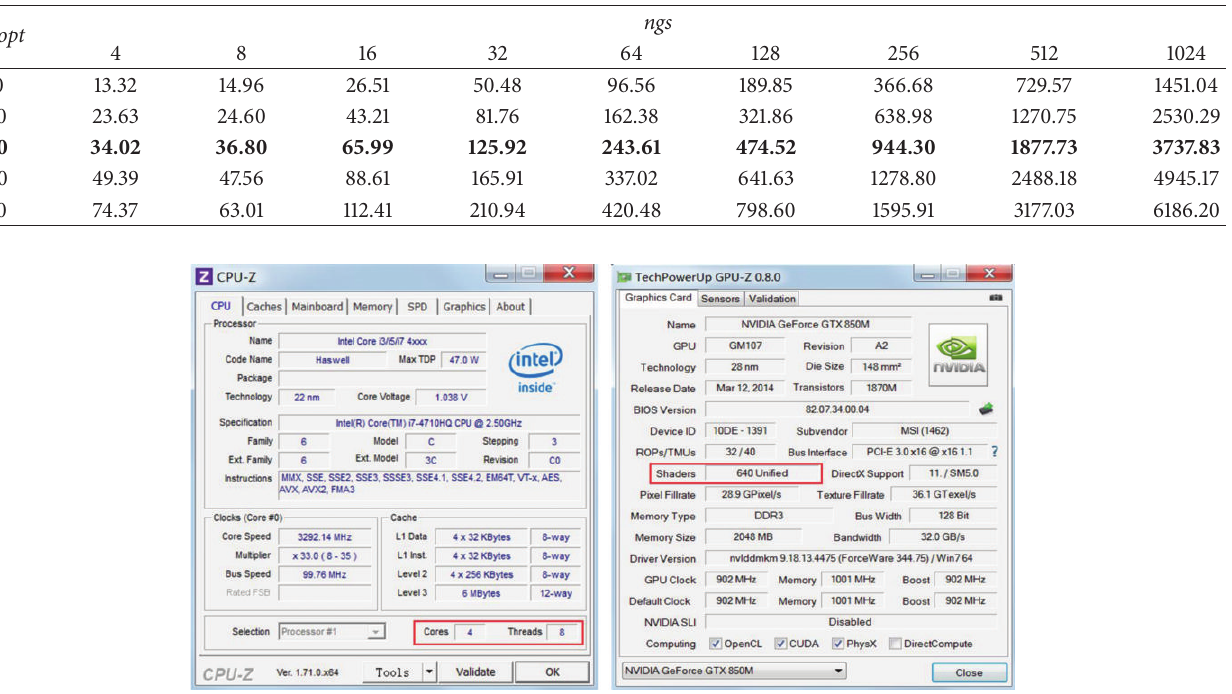
Table 2: Total execution time (seconds) of the OMP-SCE-UA.